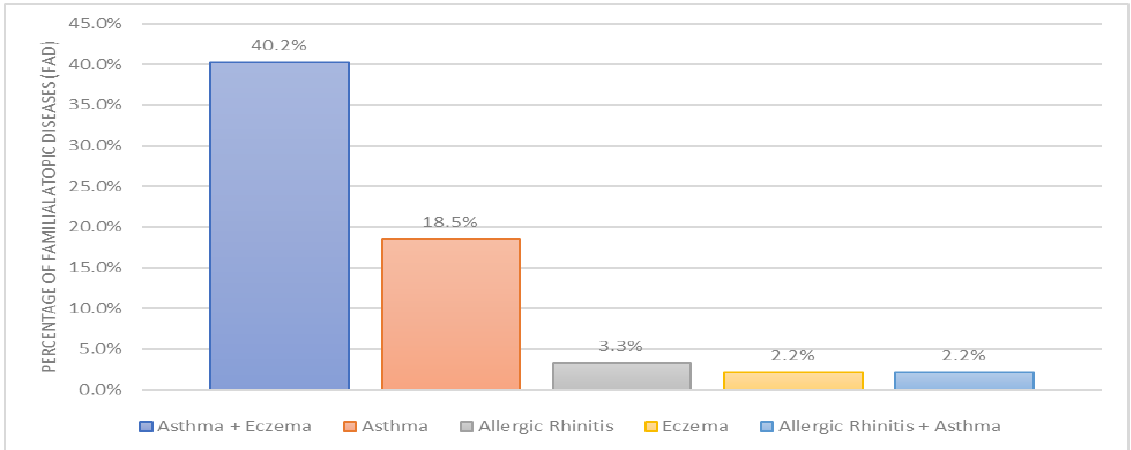
Figure 2. Percentage of Familial Atopic Diseases (FAD) among Participants The interventional pharmacist check listed